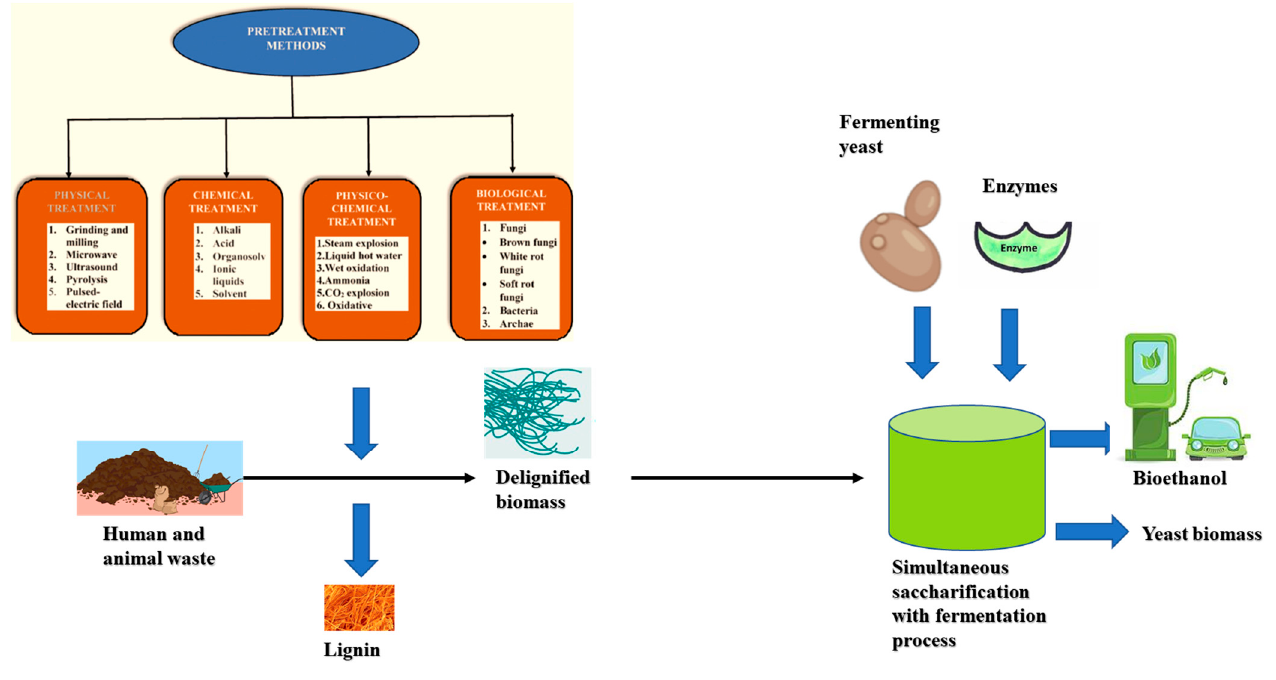
Figure 9. An overview of the sequential steps involved in the simultaneous saccharification with the fermentation